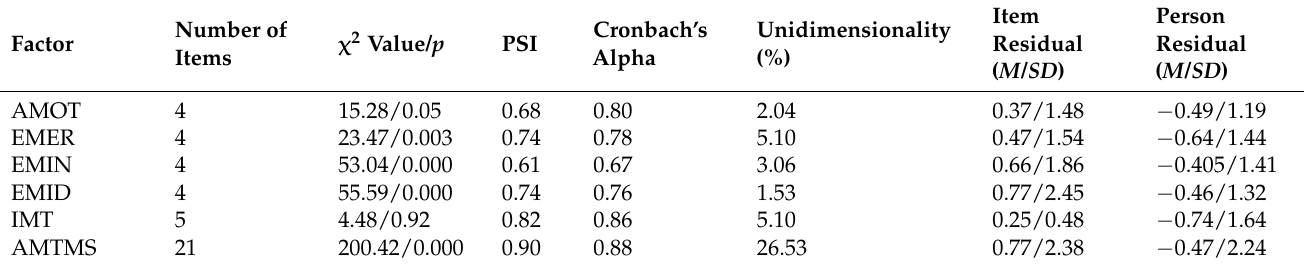
Table 3. Fit, unidimensionality and reliability indices of